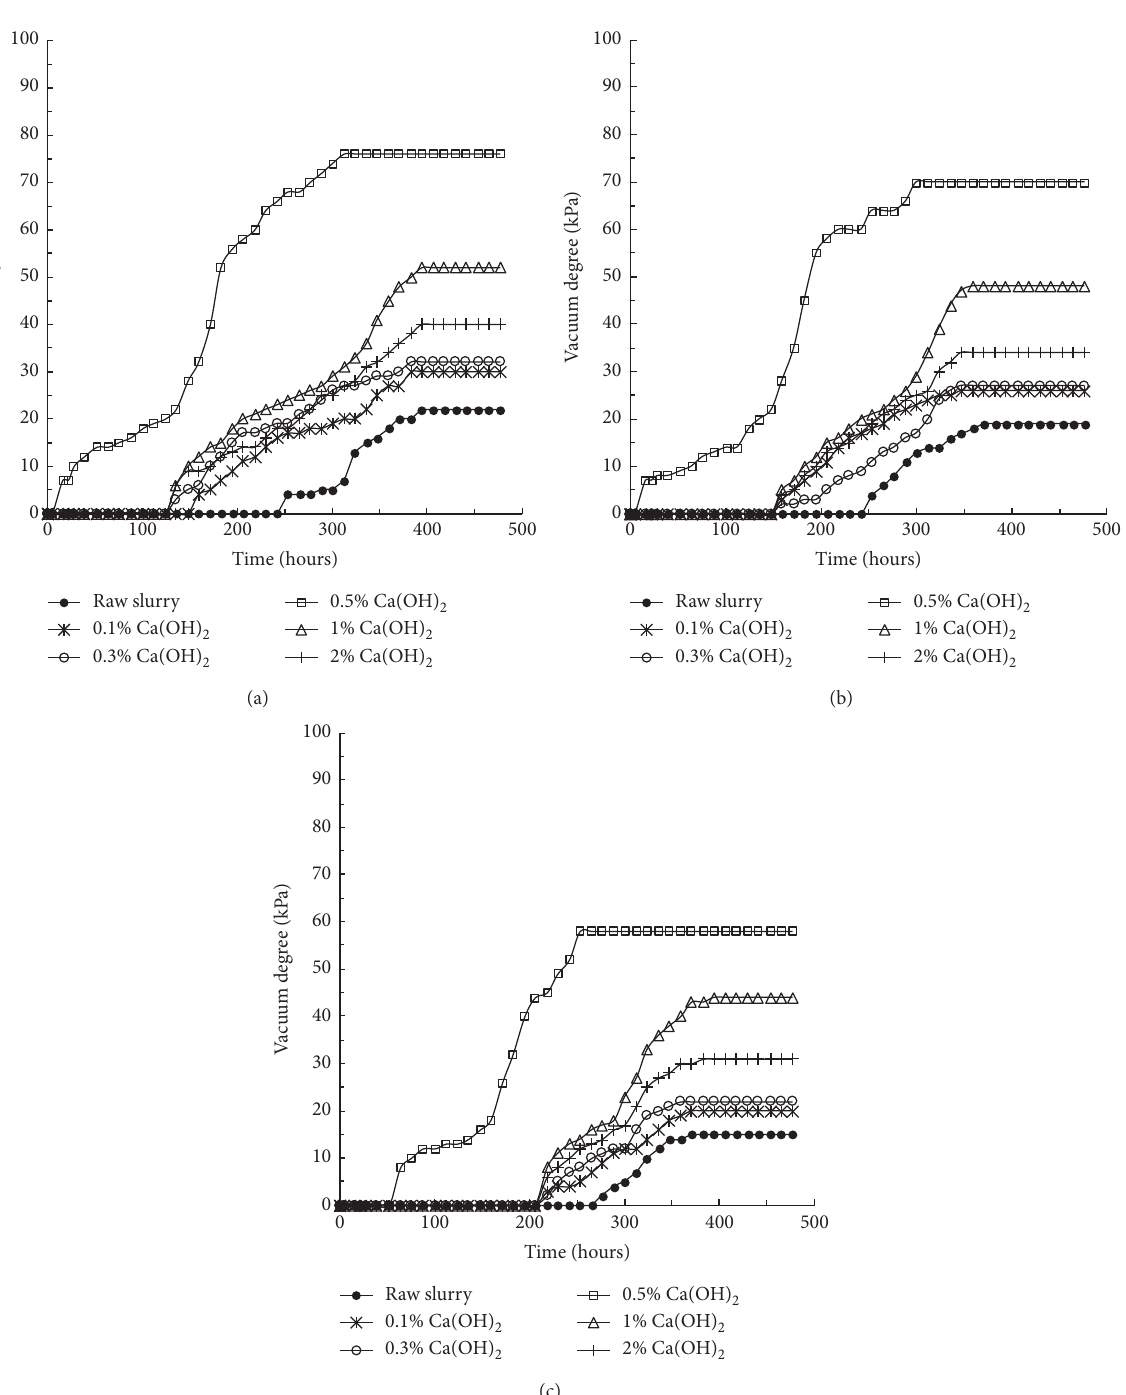
� 2 cm. (b) h � 6 cm. (c) h � 12 2 . (a) h